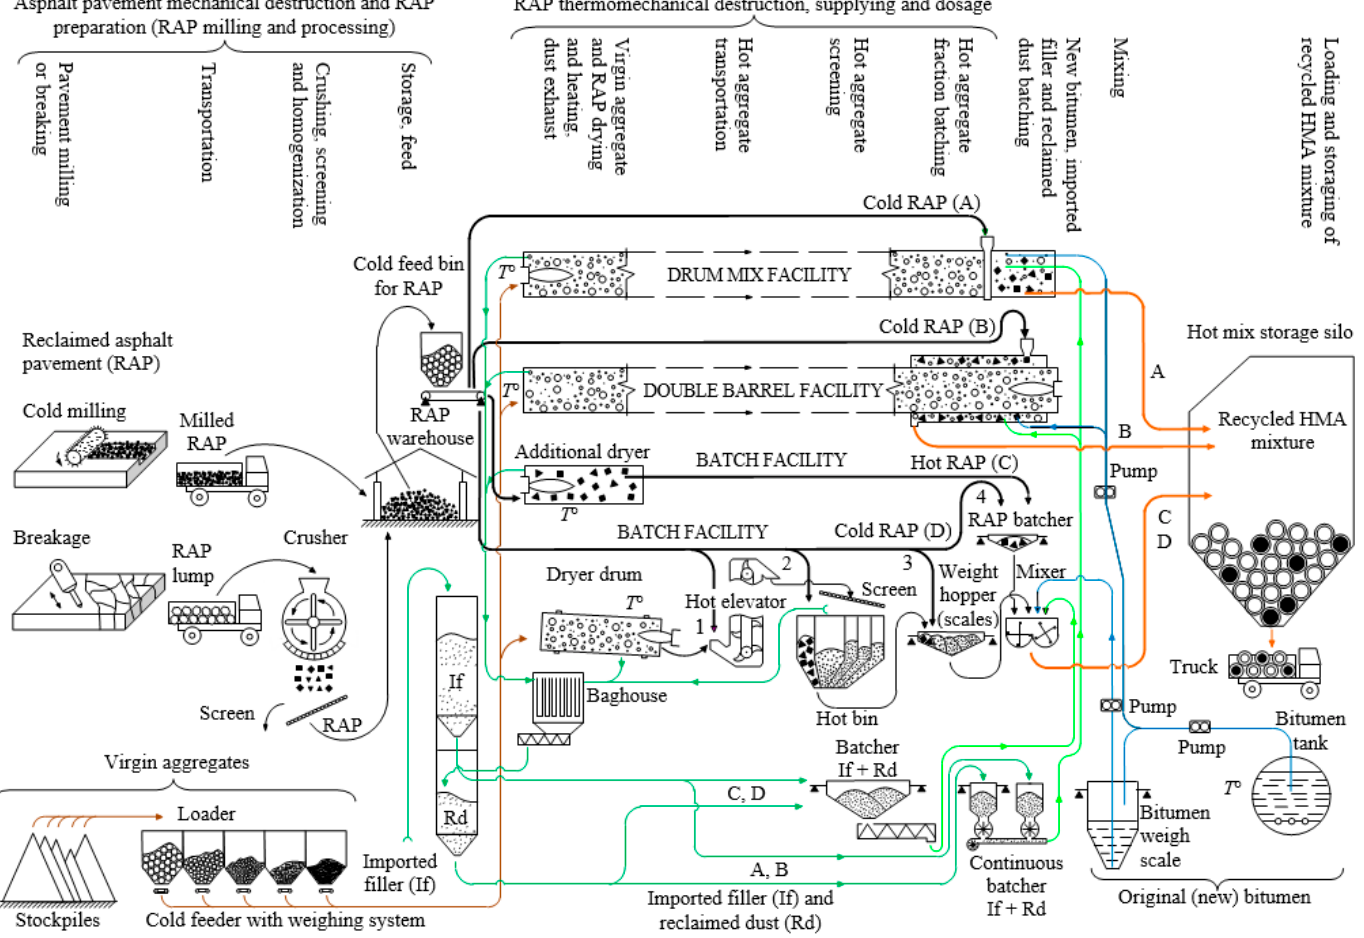
Figure 3. The model of asphalt pavement recycling operations and equipment used in batch plant ( C , D ), drum mix ( A ) and a double barrel-drum mix ( B ) when reclaimed asphalt pavement (RAP) is supplied and dosed to different places.